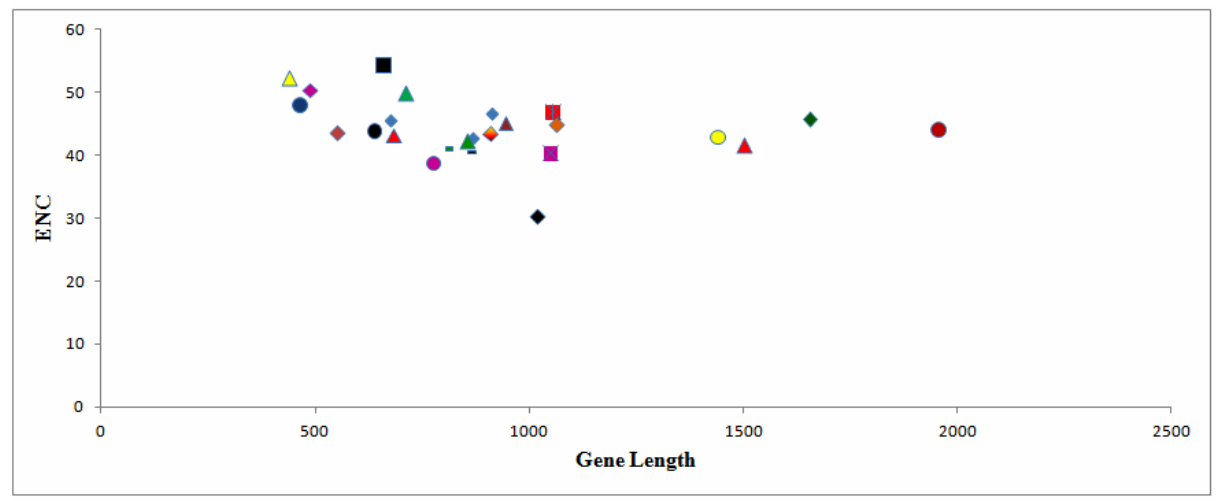
Fig. 3. Plot of ENC versus gene length for the selected cds of Haemophilus influenzae